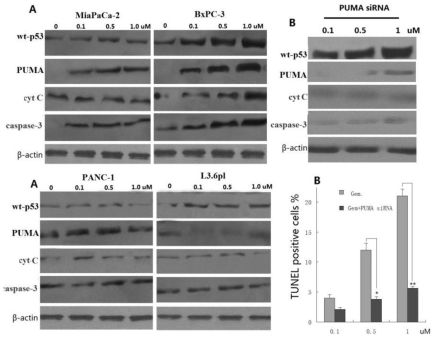
Gemcitabine modulates p53 downstream target protein expression and induces apoptosis. L3.6pl, MiaPaCa-2, BxPC-3 and PANC-1 cells were treated with gemcitabine (0.1, 0.5 and 1 μM) or combination of gemcitabine and PUMA siRNA. Levels of p53, PUMA, cytochrome C (cyt. C) and caspase-3 were determined by western blotting; (A) Basal PUMA protein was detectable in PANC-1 cells, but was undetectable in L3.6pl, MiaPaCa-2 and BxPC-3 cells. Expression of p53, PUMA, cyt C and caspase-3 proteins was significantly increased in the BxPC-3 cell line treated with gemcitabine. There was no significant increase in proteins in L3.6pl, MiaPaCa-2 and PANC-1 cells treated with gemcitabine; (B) BxPC-3 cells were transfected with PUMA siRNA in the presence or absence of 0.1–1 μM gemcitabine. PUMA and p53-responsive gene product cyt C and caspase-3 were significantly decreased, however, p53 was not affected; (C) BxPC-3 cells transfected with PUMA siRNA had a significantly decreased AI (* P < 0.05, ** P < 0.01).